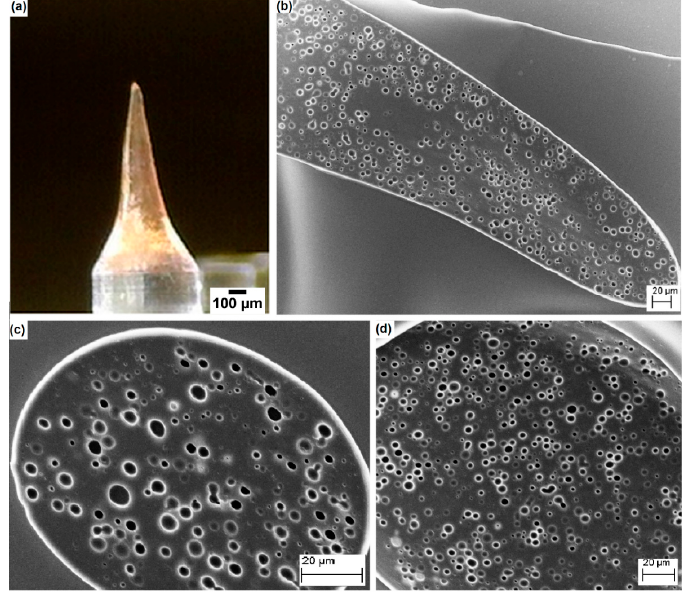
Figure 5. ( a ) Electro-drawn microneedle laying on a PDMS pillar. SEM images of ( b ) a longitudinal section; ( c ) transversal sections near the tip; and ( d ) near the base of the microneedle. Needle structure shows the same porosity of a flat layer homogeneously distributed in all its parts.